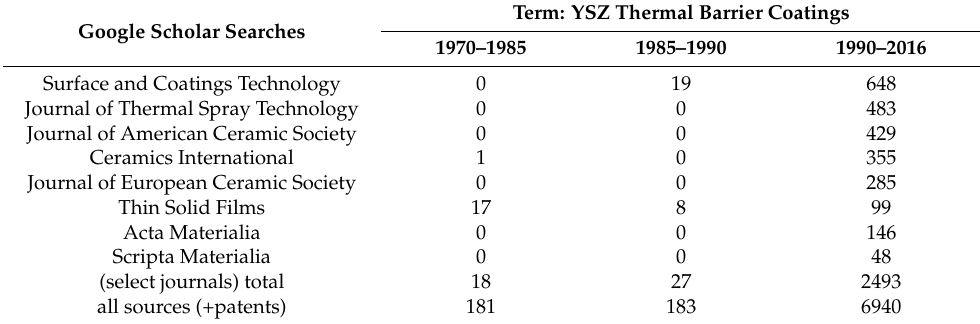
Table 1. Google Scholar hits for all words (YSZ thermal barrier coatings) anywhere in journal articles. Last row indicates hits for any source using search term YSZ and exact term “thermal barrier coating”. Google Scholar Searches